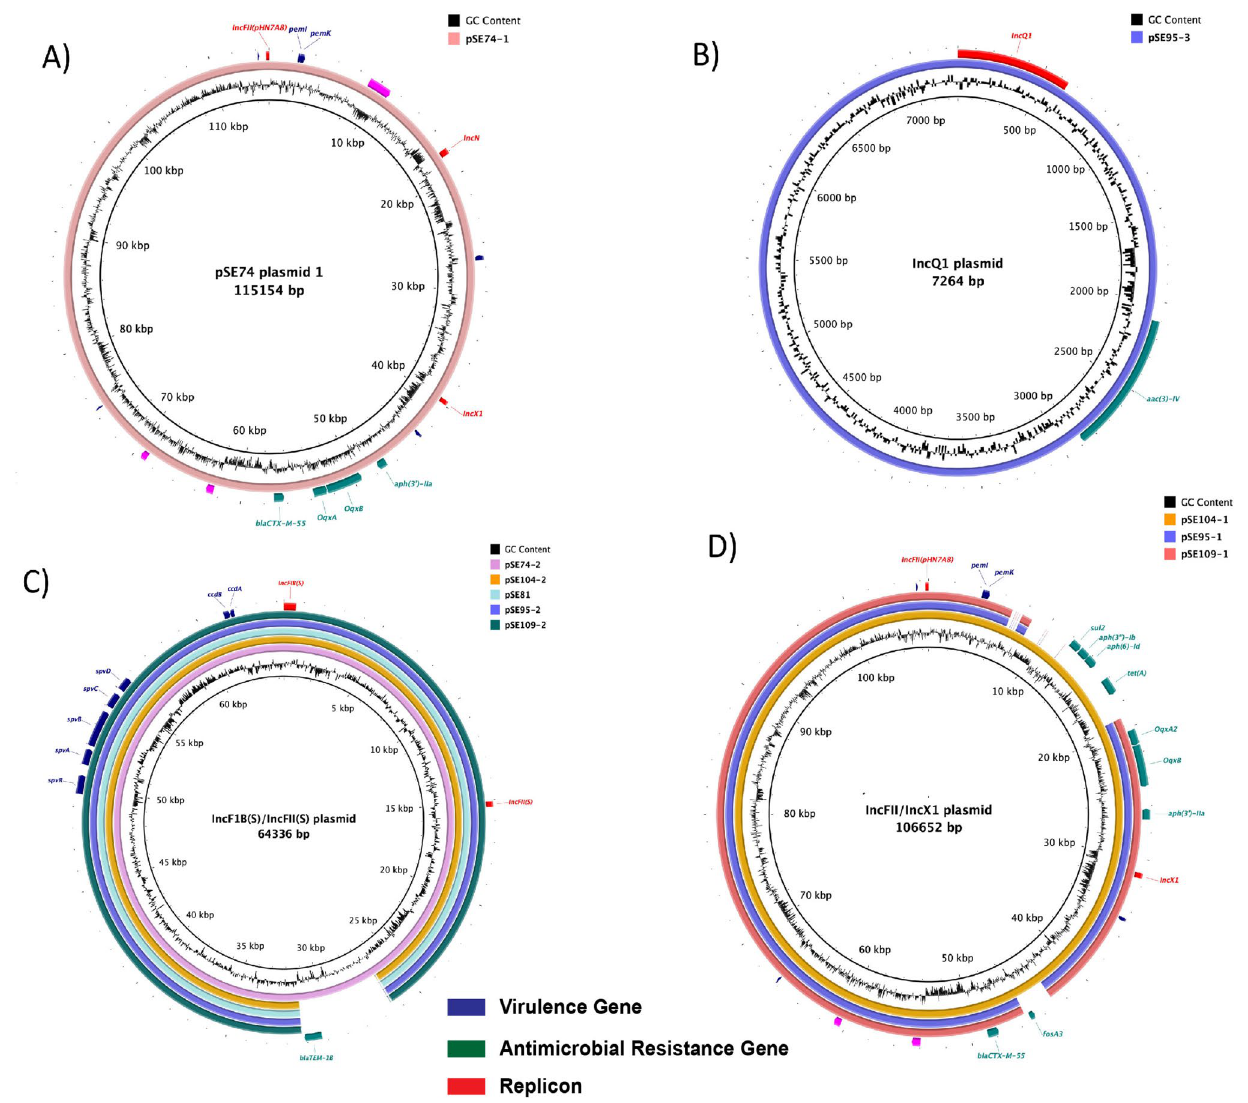
Figure 2. Genomic structure and comparison of the plasmids from closed genomes of five selected Chinese isolates. ( A ) IncFII(pHN7A8)-IncN-IncX1 hybrid plasmid, only identified from isolate SE74; ( B ) IncQ1 plasmid; ( C ) IncF1B(S)-IncFII(S) hybrid plasmid; ( D ) IncFII(pHN7A8)-IncX1 hybrid plasmid. Featured genes including replicons, ARGs, and virulence genes are color coded on the bottom of the